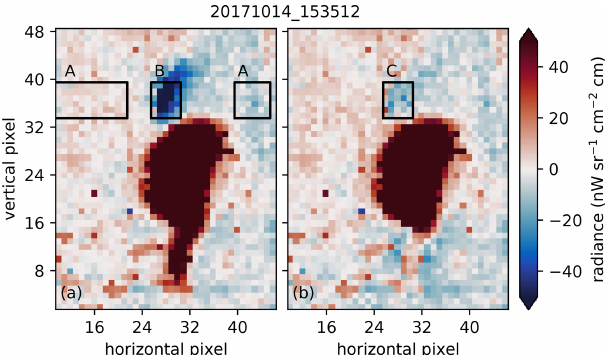
Figure 8. Panel (a) shows the average radiance of a moon image from 14 October 2017; note the two strong parasitic images above and below. Panel (b) shows the same image after parasitic image correction was applied. The same background was subtracted from both images, and was computed for each row individually from the median over all pixels outside the columns containing moon- affected pixels. The black rectangles indicate regions related to the spectra shown in Fig.